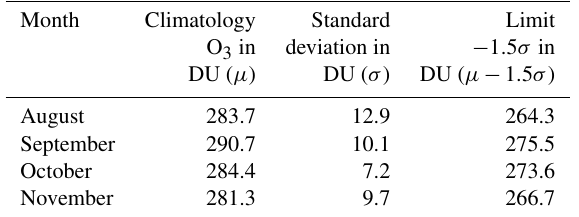
Table 1. Monthly climatological values, their standard deviations, and limit − 1 . 5 σ for August, September, October, and November for the South Space Observatory